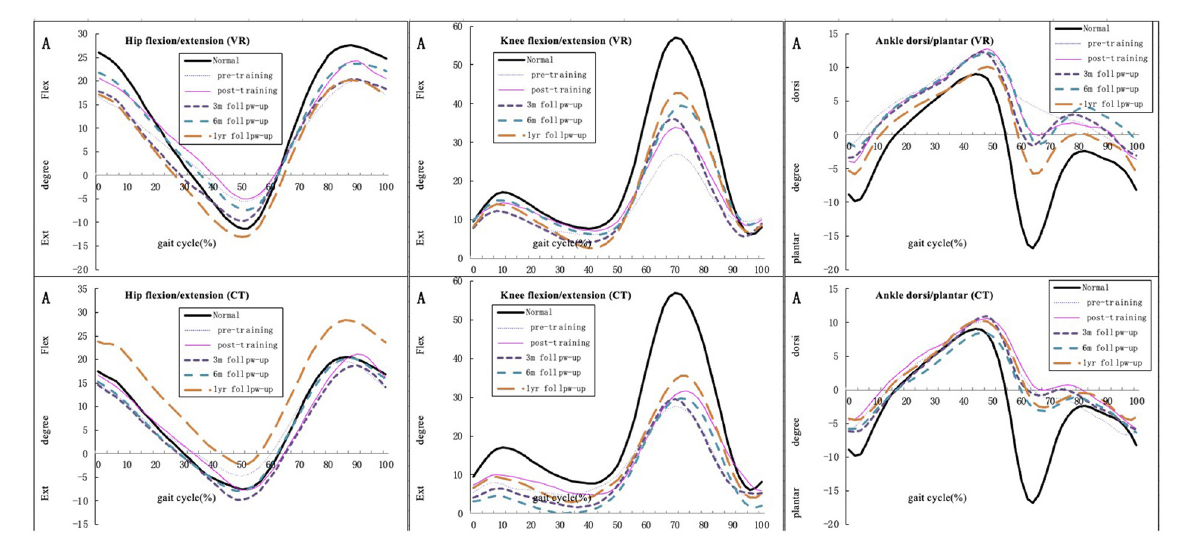
FIGURE3 Mean hip, knee, and ankle joint kinematic curve for all participants in the sagittal plane of both groups during pre-, post-training and follow-up (compared with normal gait